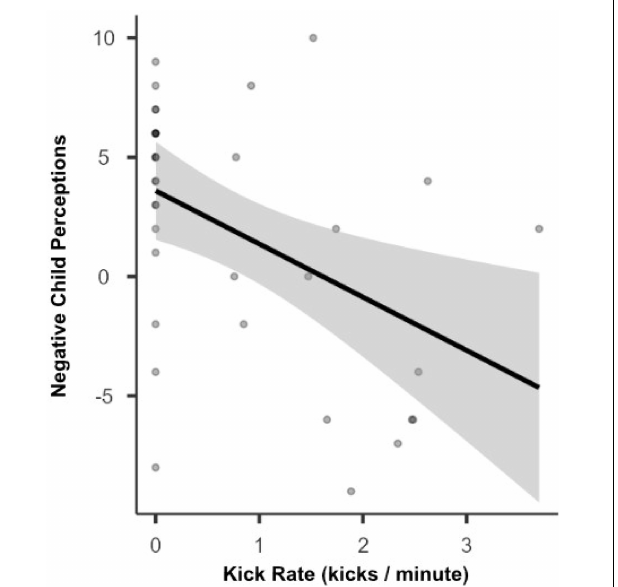
FIGURE 4 | Relation between Fetal Kick Rates and Parent Negative Perceptions. This figure demonstrates the link between in utero fetal kick rates (FKC) and negative parent perceptions toward their child (EMQ-X) around 3 months postpartum.